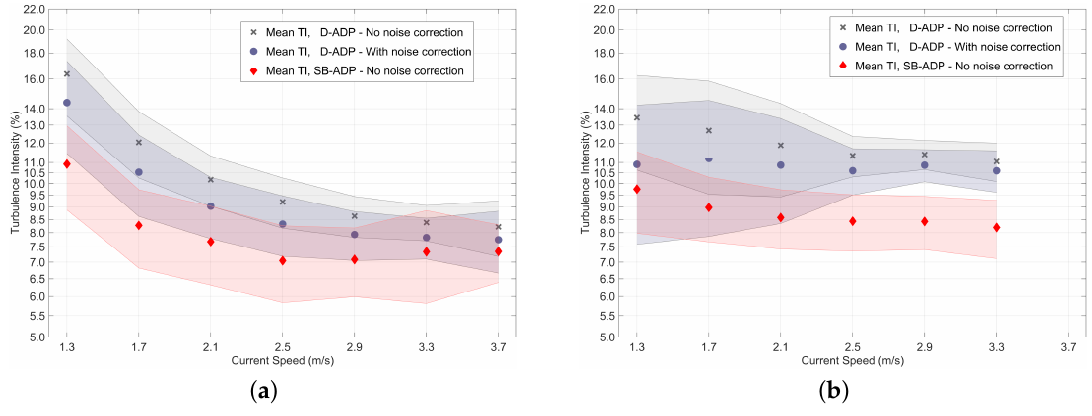
Figure 13. Turbulence intensity against current speed for ( a ) ebb and ( b ) flood tides. Filled circles show mean values of TI per velocity bin derived from noise-corrected D-ADP data. Crosses show equivalent uncorrected values. Mean values of TI measured at hub-height via SB-ADP are marked with red diamonds. Shaded areas, matching mean-marker colours, represent plus and minus one standard deviation from these means. ( a ) Ebb Tide TI via D-ADP and SB-ADP. ( b ) Flood Tide TI via D-ADP and